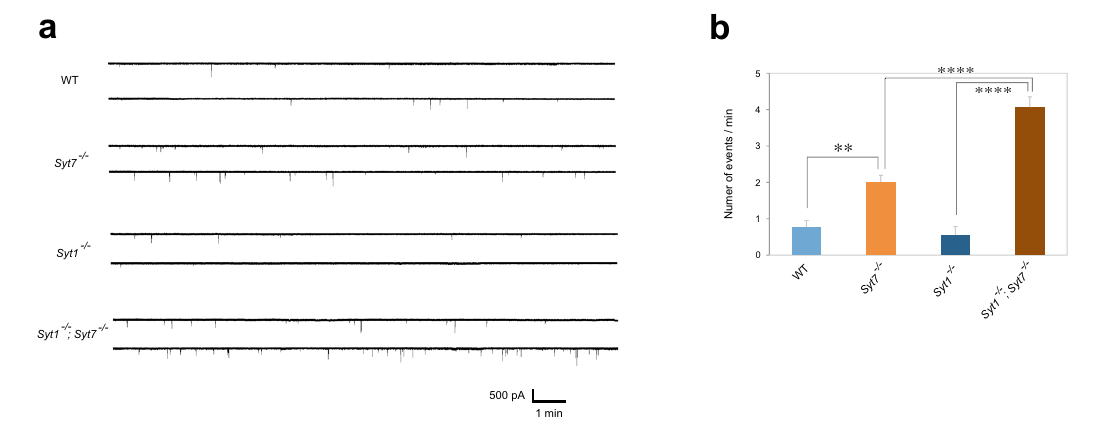
Figure 4. Spontaneous miniature synaptic currents. ( a ) Representative traces for each genotype in the presence of 3 μM Tetrodotoxin (TTX), which inhibits action potentials. Concentration of Ca 2+ was 1.5 mM. ( b ) Miniature synaptic currents counted during 10 min and shown as number of events per minute for each genotype. The four groups were analyzed with ordinary one-way ANOVA and significant difference between the groups